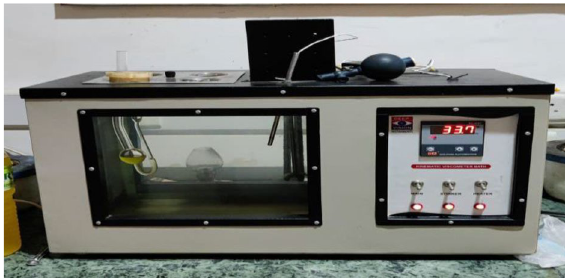
Figure 2. Viscosity